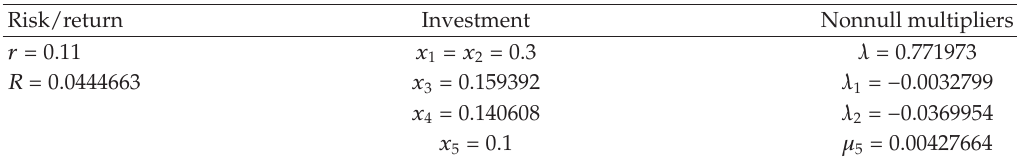
Table 8: An optimal